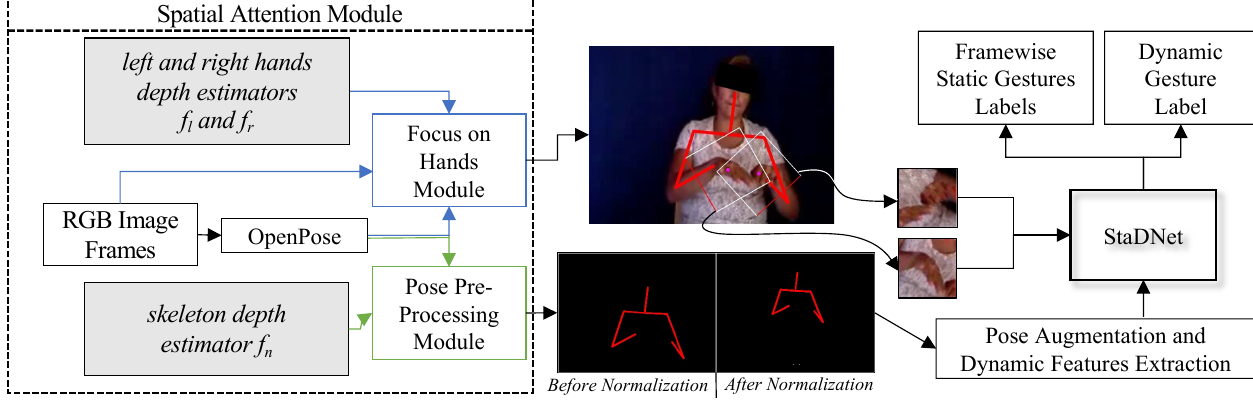
Figure 1. Illustration of our proposed framework. In Spatial Attention Module, we mainly have learning-based depth estimators (grey boxes), Focus on Hands (FOH) Module and Pose Pre-Processing (PP) Module. 2D skeleton is extracted by OpenPose . FOH exploits hand coordinates obtained from the skeleton and crops hand images with the help of hand depth estimators, while PP performs scale and position normalization of the skeleton with the help of skeleton depth estimator. The features from the normalized pose are extracted by Pose Augmentation and Dynamic Features Extraction Module and are fed to StaDNet together with the cropped hand images. StaDNet detects frame-wise static gestures as well as dynamic gestures in each